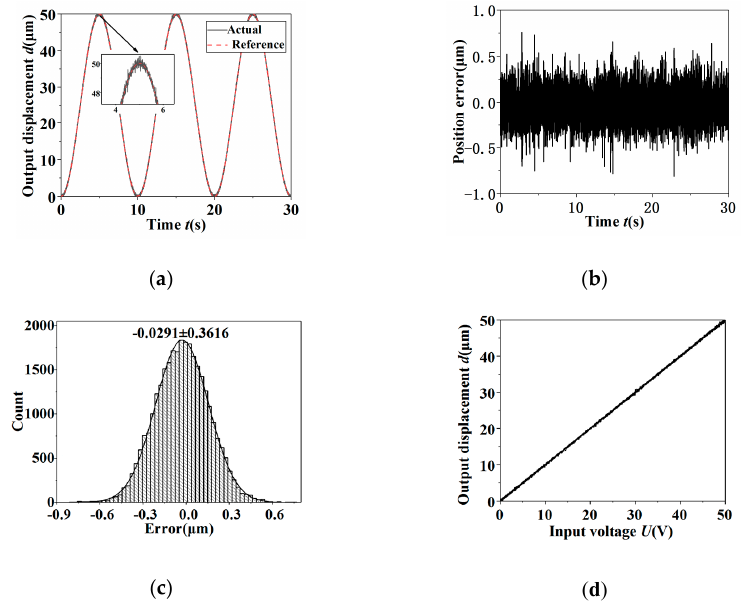
Figure 9. The output results of open ‐ loop control of the sinusoidal signal for the tip displacement. ( a ) The reference signal and output response; ( b ) the error; ( c ) the hysteresis curve.